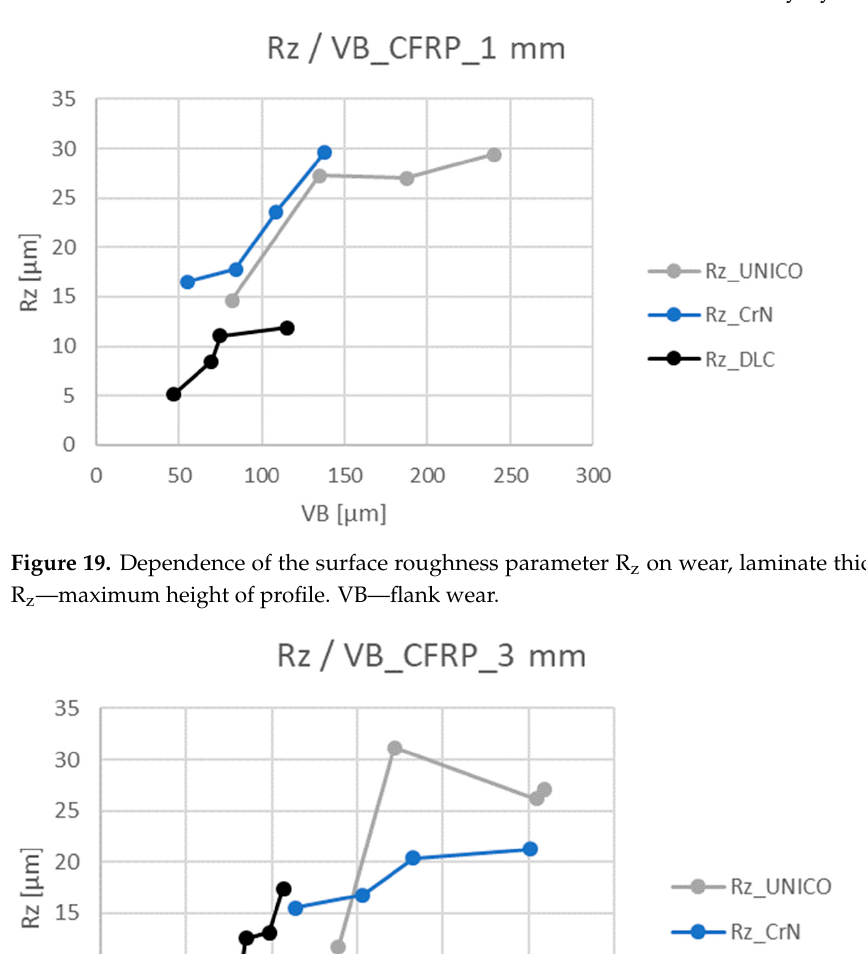
Figure 18. Dependence of the surface roughness parameter R a on wear, laminate thickness 3 mm. R a —arithmetical mean high. VB—flank wear.